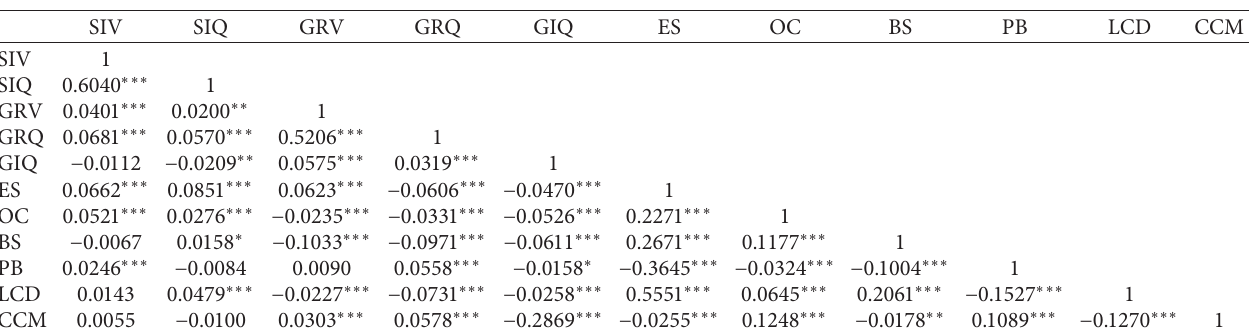
Table 3: Correlation analysis.